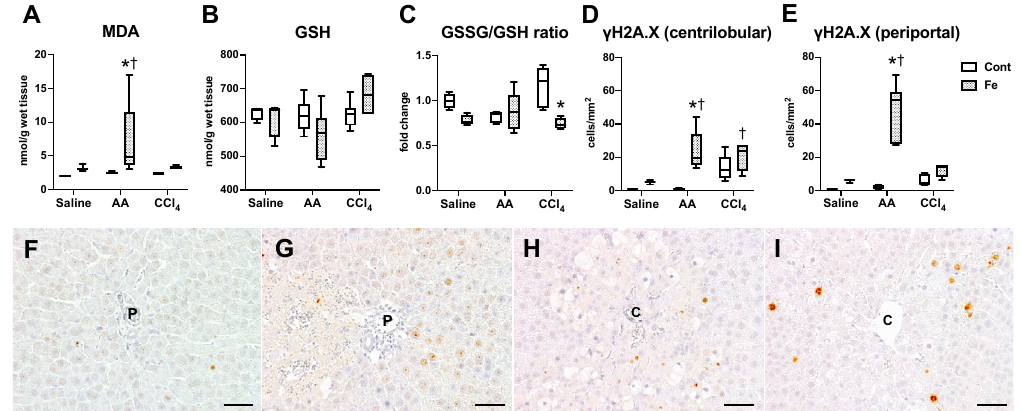
Figure 6. Hepatic content of malondialdehyde (MDA); ( A ), glutathione (GSH); ( B ) and the ratio of glutathione disulfide (GSSG) to GSH ( C ). The number of γ H2A.X-positive hepatocytes in the centrilobular ( D ) and periportal region ( E ) of the liver. * p < 0.05 vs. control diet group with same chemical administration (diet factor), † p < 0.05 vs. saline group with same diet feeding (chemical factor), by Sidak’s multiple comparison. Representative images of immunohistochemistry for γ H2A.X in the liver of Cont-AA ( F ), Fe-AA ( G ), Cont-CCl 4 ( H ), and Fe-CCl 4 ( I ) groups. The number of γ H2A.X-positive periportal (Zone 1) hepatocytes is higher in the Fe-AA than in Cont-AA group, while the number of γ H2A.X-positive centrilobular (Zone 3) hepatocytes does not differ significantly between Cont-CCl 4 and Fe-CCl 4 groups. P, portal vein; C, central vein. Bar = 50 µm.